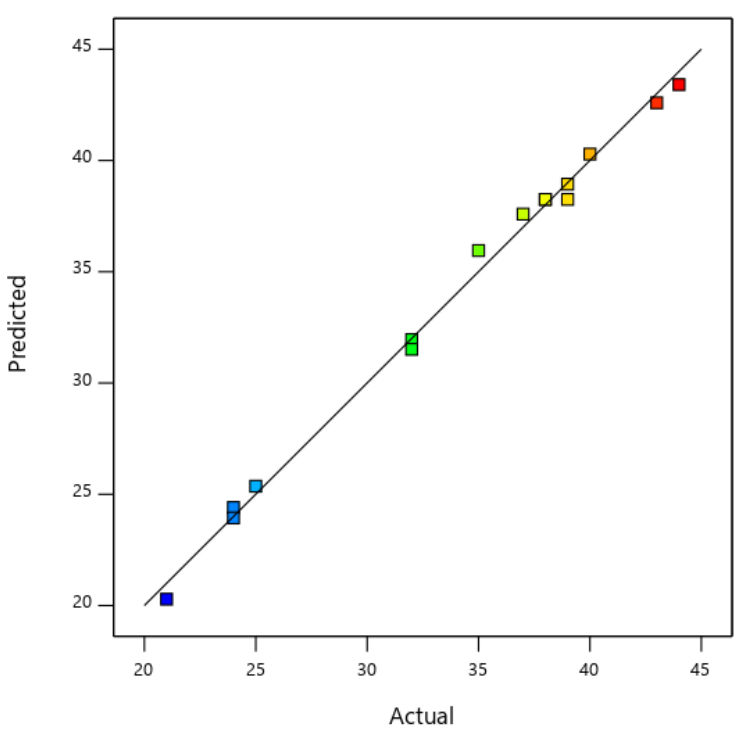
Figure 2. Carbon product predicted and actual yield derived from the RSM model.